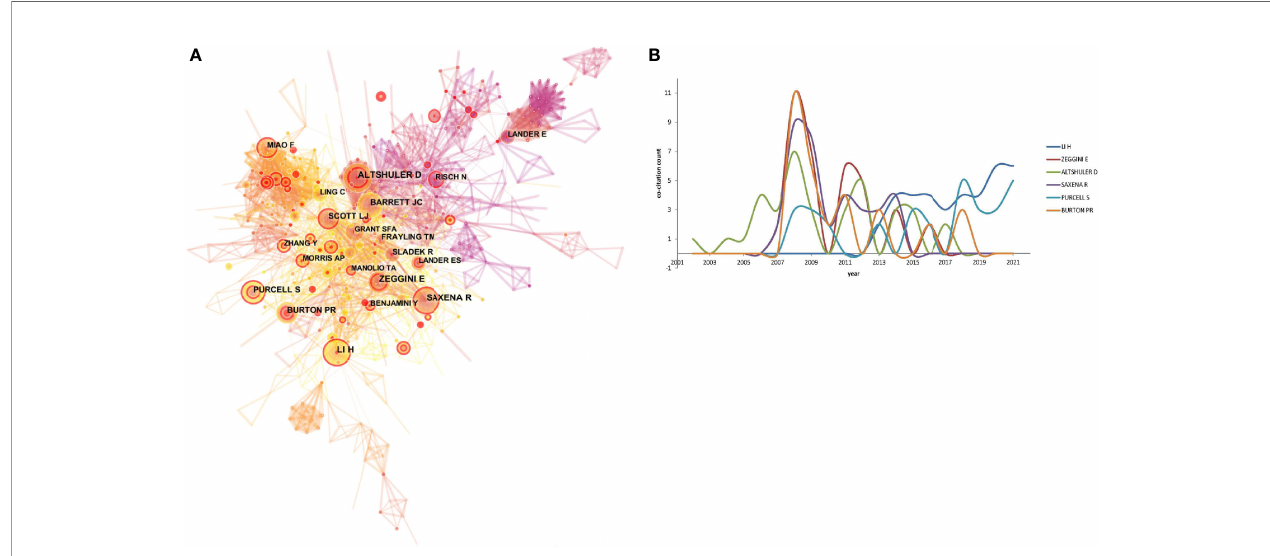
FIGURE 4 | (A) The author co-citation network. The con fi gurations set as: pruning path fi nder, algorithm log-likelihood rate (LLR), time slice l, top N 50 per year, link- retaining factor (LRF) = 3, look back years (LBY) = 5, and e l = 1. The node size referred to the number of citations of a speci fi c author, while the links represented the frequency of the co-citation for two authors. The higher betweenness centrality (betweenness centrality > 0.l) represented the leading researchers and was expressed as a purple circle around the node. (B) The top 6 co-cited author with annul citation